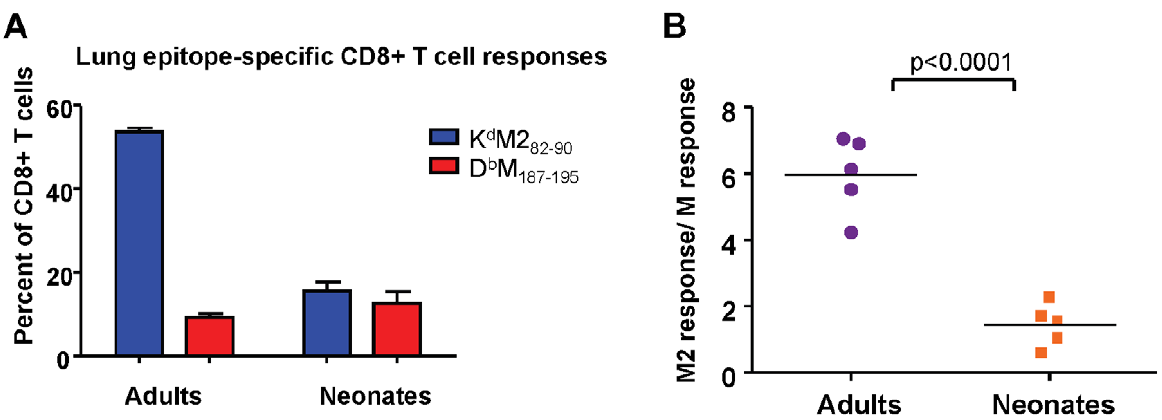
Figure 4. Epitope-specific CD8 + T cell responses following infection with rAd5-MM2. (A) K d M2 82-90 and D b M 187-195 tetramer-binding CD8 + T cells in the lungs of mice infected as adults or neonates 7 days earlier with replication-defective rAd5 vector expressing M and M2 in the form of a fusion protein. (B) Epitope-specific CD8 + T cell response ratios. Data are representative of two independent experiments with 5 mice/group. Error bars represent the SEM.